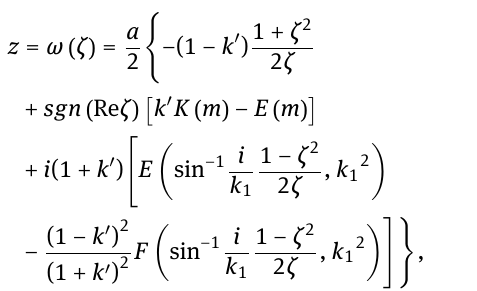
The mapping function of the plane exterior to the slot of Figure 1 onto a unit circle [5–8] has the